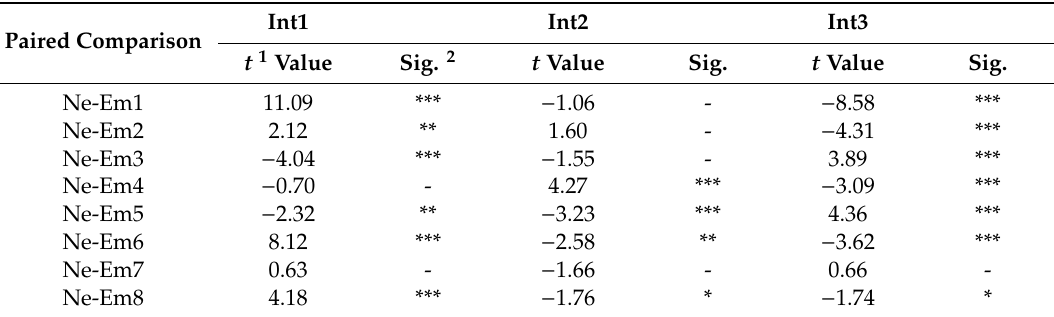
Table 9. t -test for probability distribution of driving